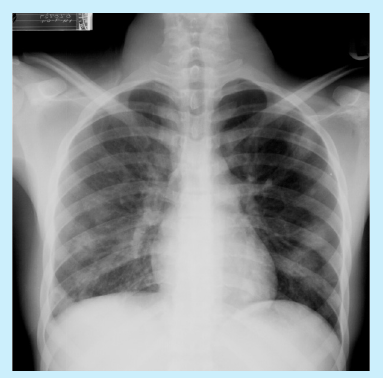
Fig.1 Chest X-ray demonstrates cavitating nodules, a small right-sided pleural effusion and soft-tissue fullness in the neck